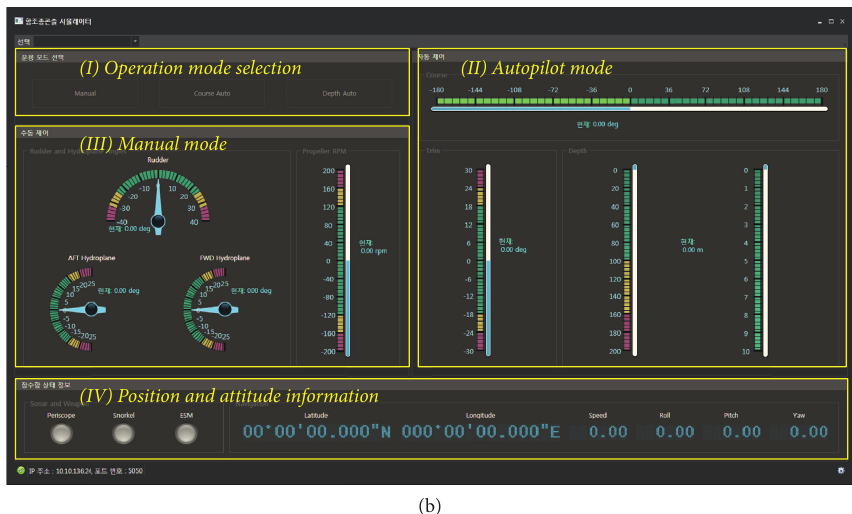
Figure 7: Graphical user interfaces (GUIs) of the developed simulators: (a) CM simulator; (b) ship steering simulator.